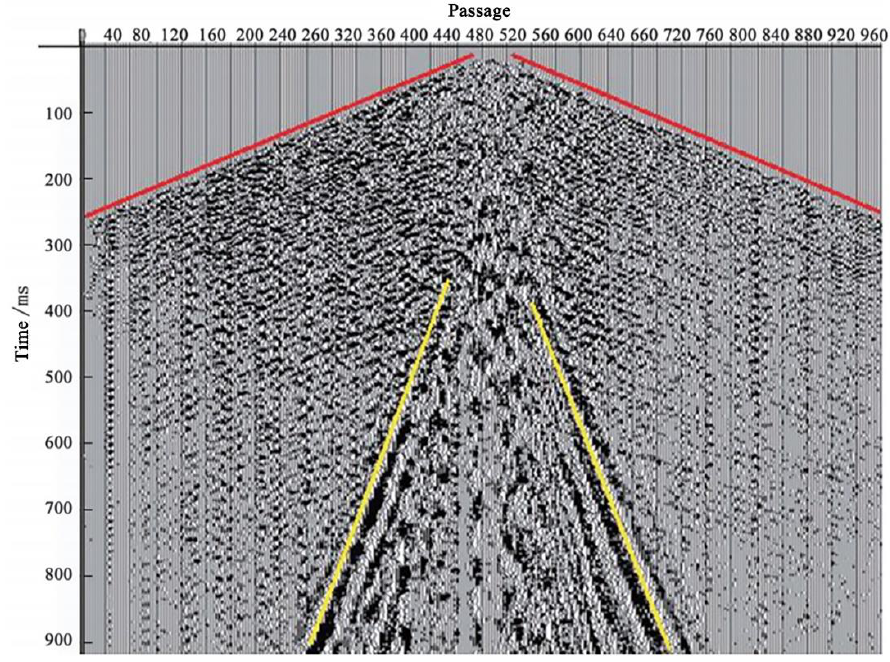
Figure 24. DAS earthquake wave test data [85].